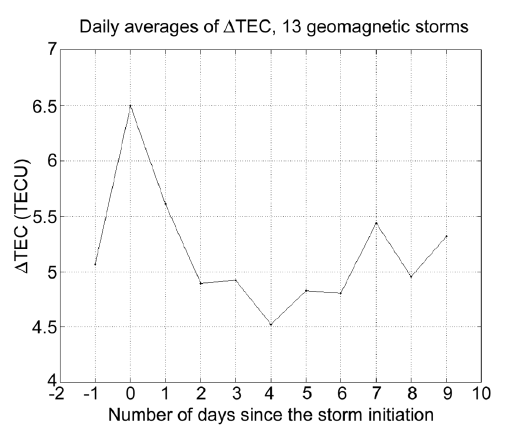
Fig. 7. Superposed epoch analysis on 13 geomag- netic storms of the daily averages of the difference between GPSTEC and ITEC as a function of number of days since storm